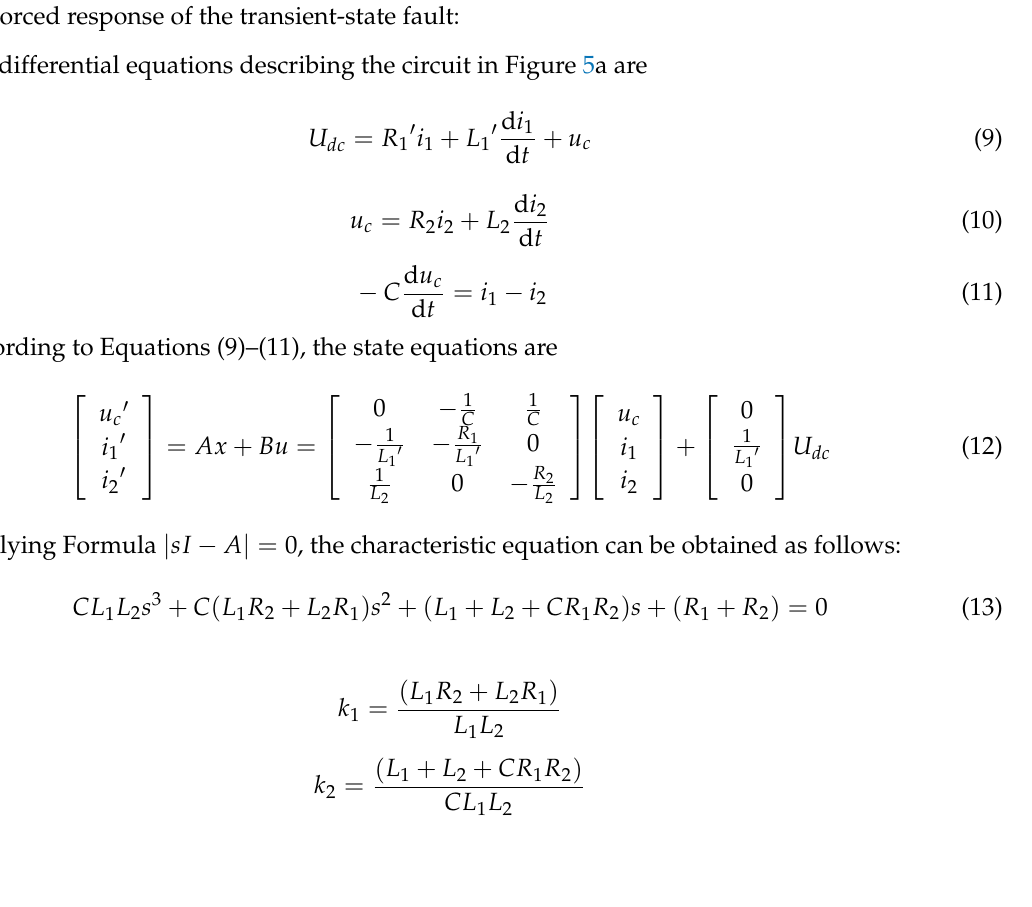
Figure 5. The equivalent transient-state circuit model of VSC: ( a ) the natural response process equivalent circuit; and ( b ) the forced response process equivalent circuit.